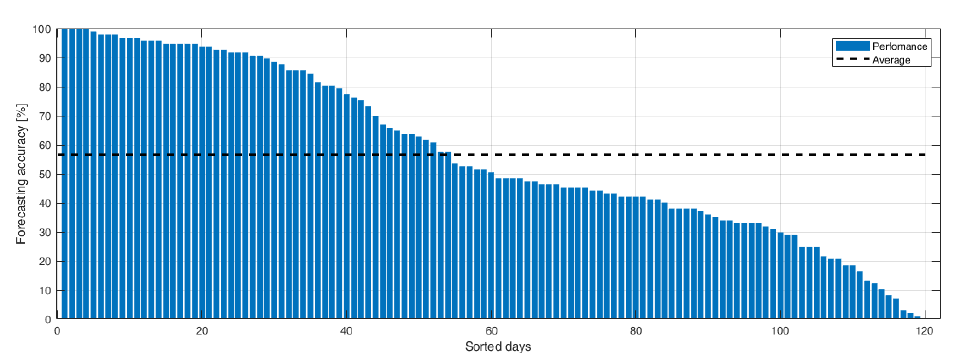
Figure 10. Sorted daily forecasting performance corresponding to a time horizon of 10 min.